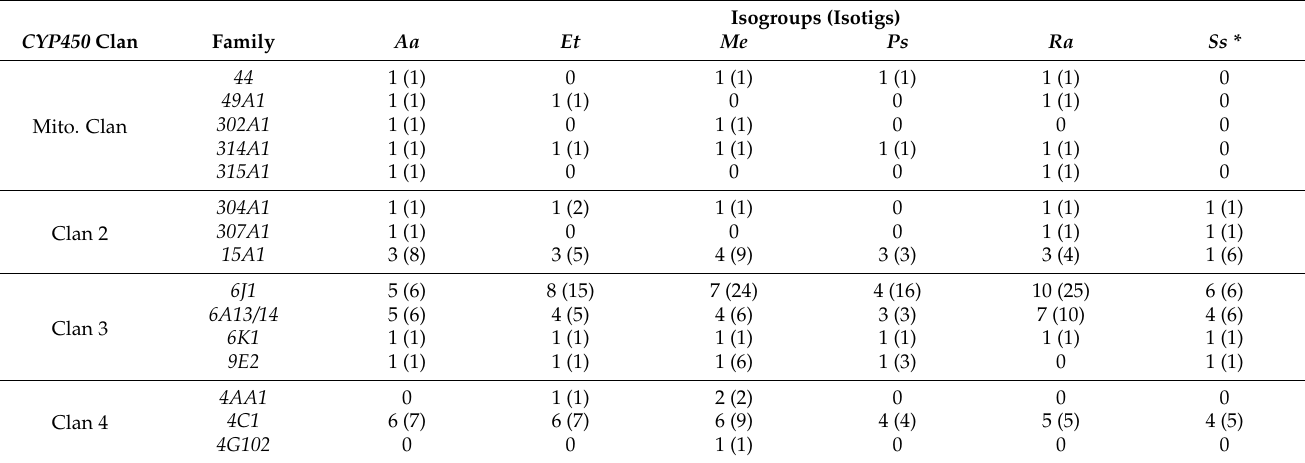
Table 1. Cytochrome P450s of the